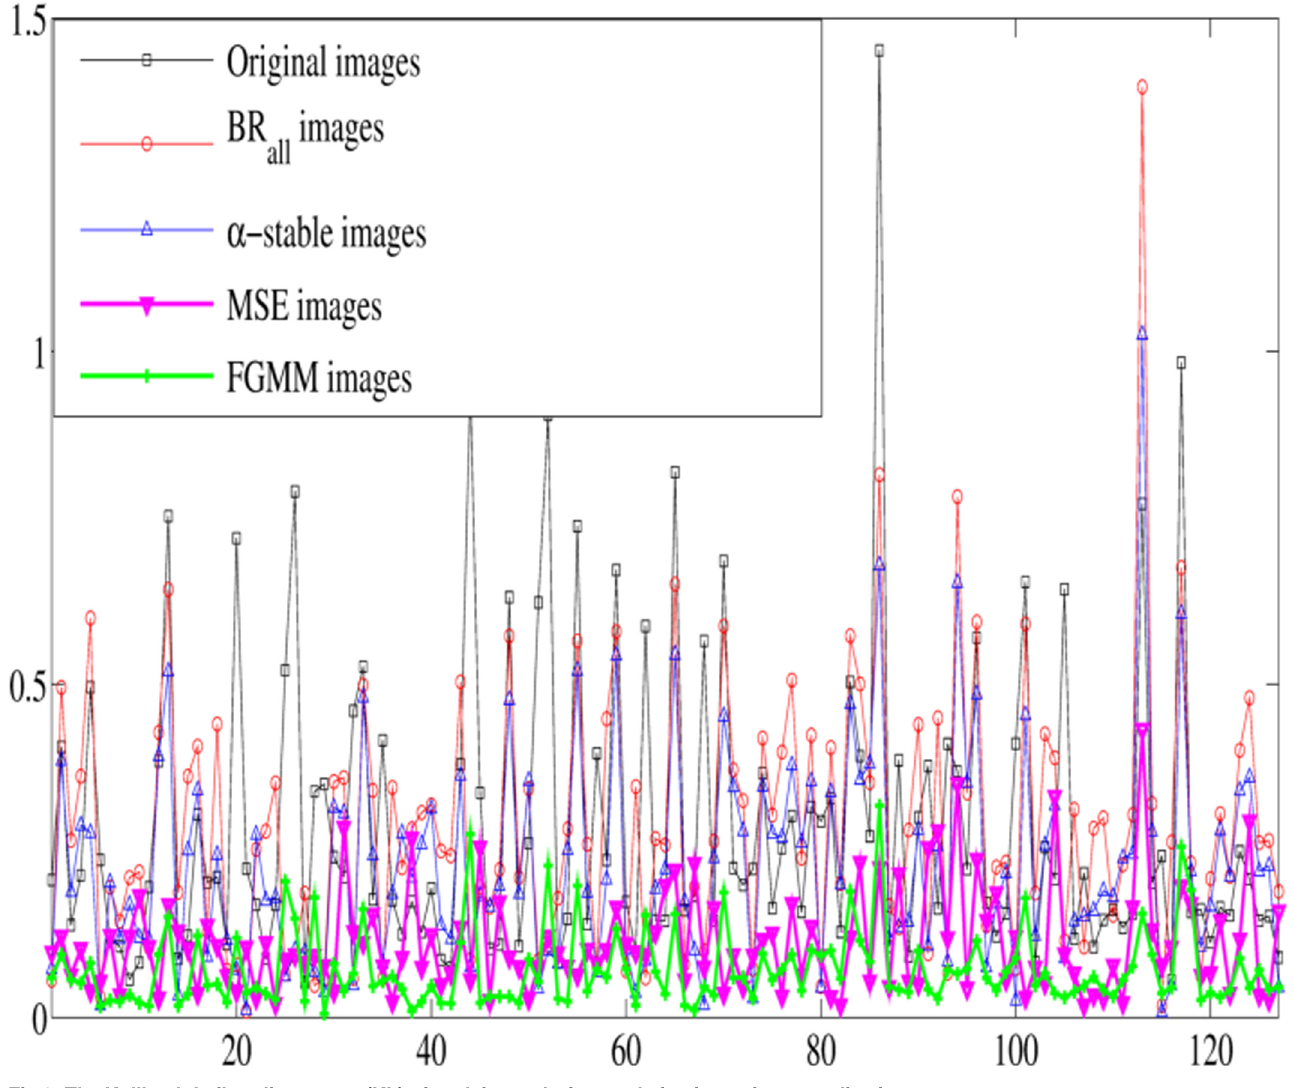
Fig 6. The Kullback-Leiber divergence (KL) of each image before and after intensity